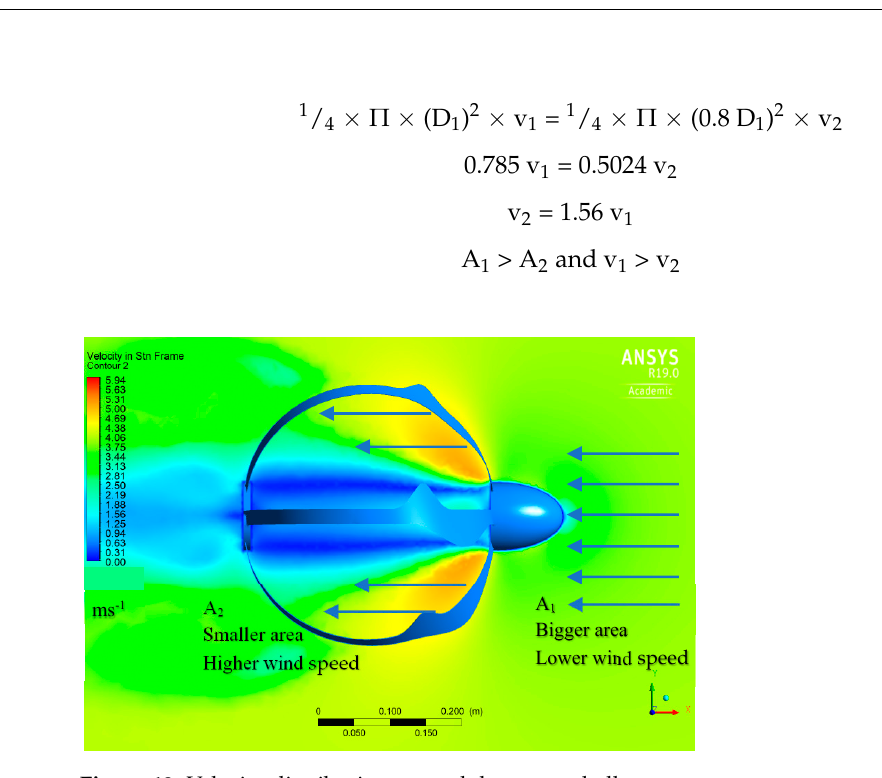
Figure 15. Pressure and velocity distribution across the distribution line. 5.2.2. Analytical Evaluation of the Annual Wind Turbine Energy Kinetic energy is the energy of motion of the moving air and can be calculated as: E c = ½ ƍ V v 2 The air flowing through area A per second is expressed by: V = A × v (m 3 /s) So, wind power can be calculated by: P = ½ ƍ × A × v 3 (W) Table 4 shows the calculated kinetic power, the annual potential wind power, the electric power output of the wind turbine (assuming Betz limit and yield losses), and the real yearly wind turbine energy production for V 100 and V 200 EBWTs for two different in- let wind speeds (5 m/s and 8 m/s). Table 4. Specifications and output of the wind turbines. Type Wind Speed ( m/s ) Rotor Diameter ( m )